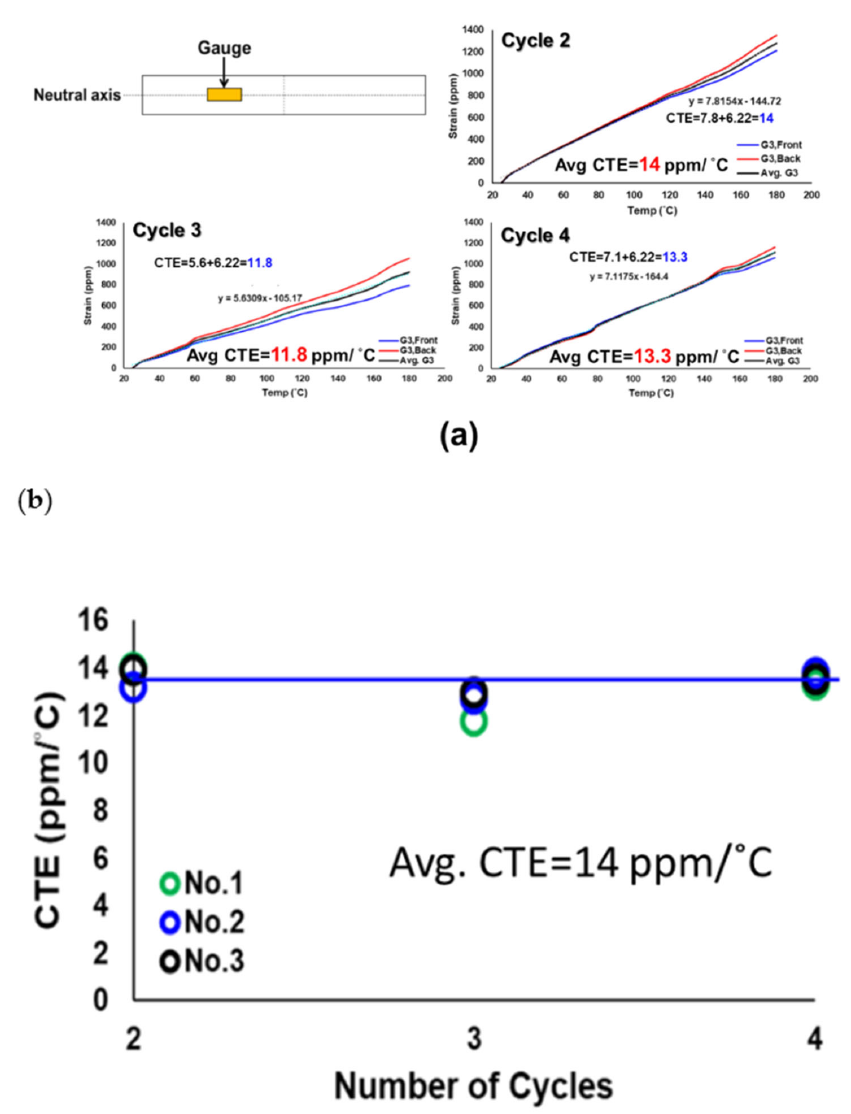
Figure 9. ( a ) Typical strain data from the front and back gauges located at the neutral axis of a socket during the second, third, and fourth thermal cycling loading, and ( b ) the CTEs of three sockets, obtained from gauges for these three thermal cycles.